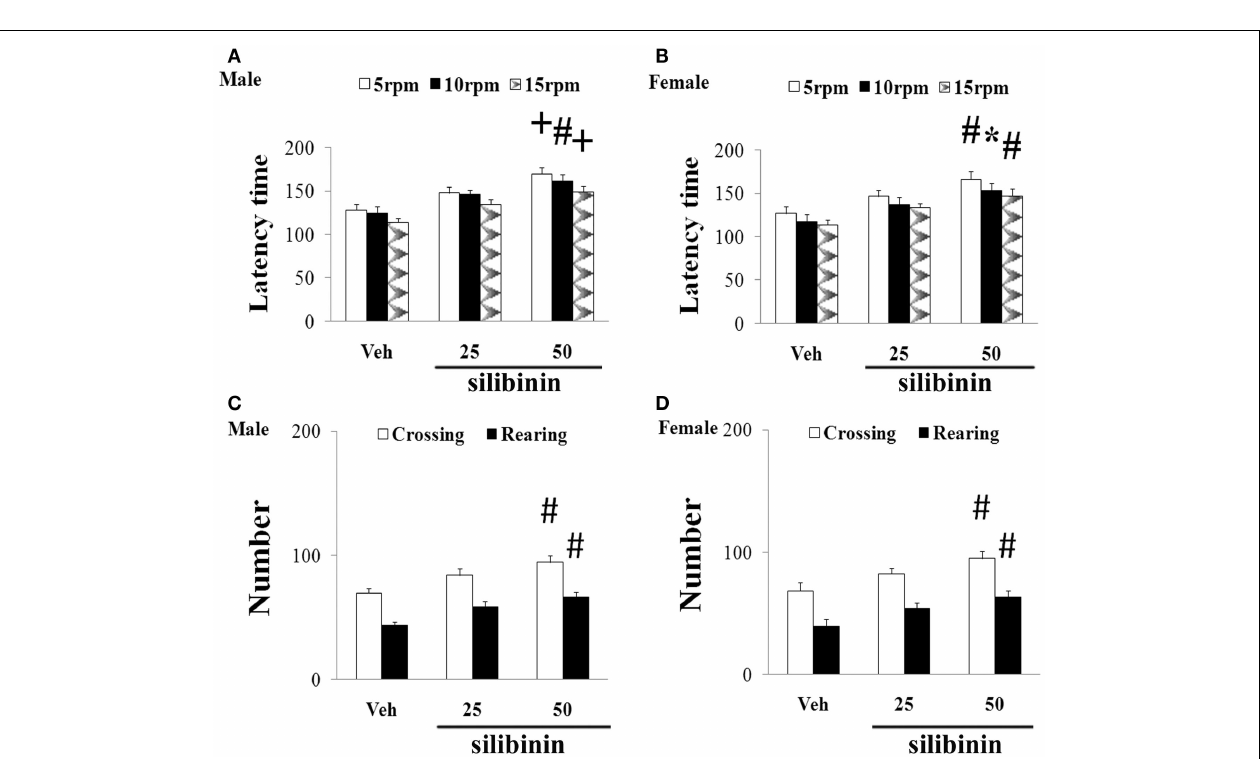
FIGURE 6 | Effect of silibinin treatment on motor behavior of aging male (A,C) and female (B,D) rats with increased neonatal iron intake in rotarod test (A,B) and open-field test (C,D) . Results are expressed as mean ± SEM. N = 8–10. * p < 0.05, # p < 0.01, and + p < 0.005, compared with the aging rats treated with Veh. Veh, vehicle.